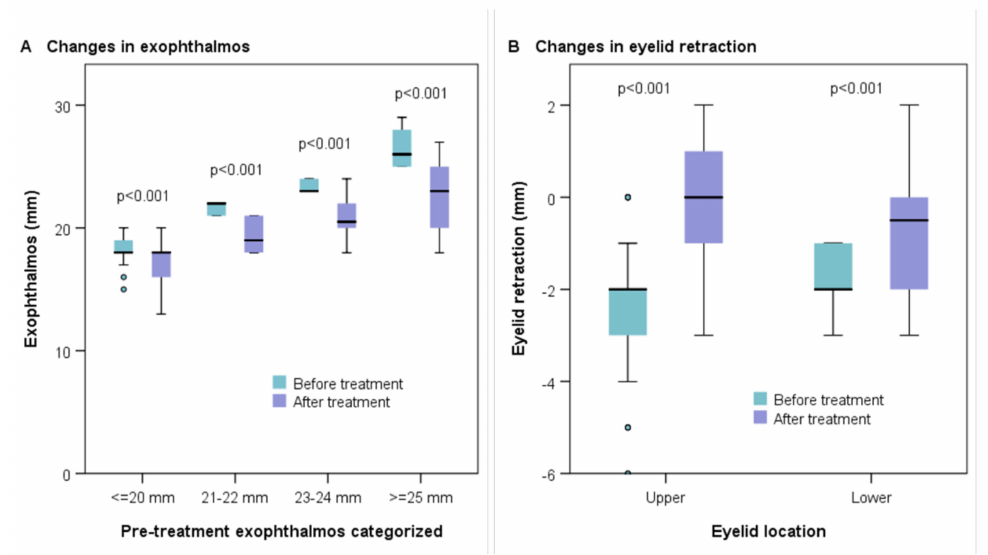
Figure 2. Exophthalmos and eyelid retraction before and after treatment with tocilizumab. The box plots show the changes in exophthalmos (categorized in four groups based on the initial measurement of exophthalmos) ( A ) and eyelid retraction (upper and lower) ( B ) before and after treatment with tocilizumab. P -values were calculated with the Wilcoxon